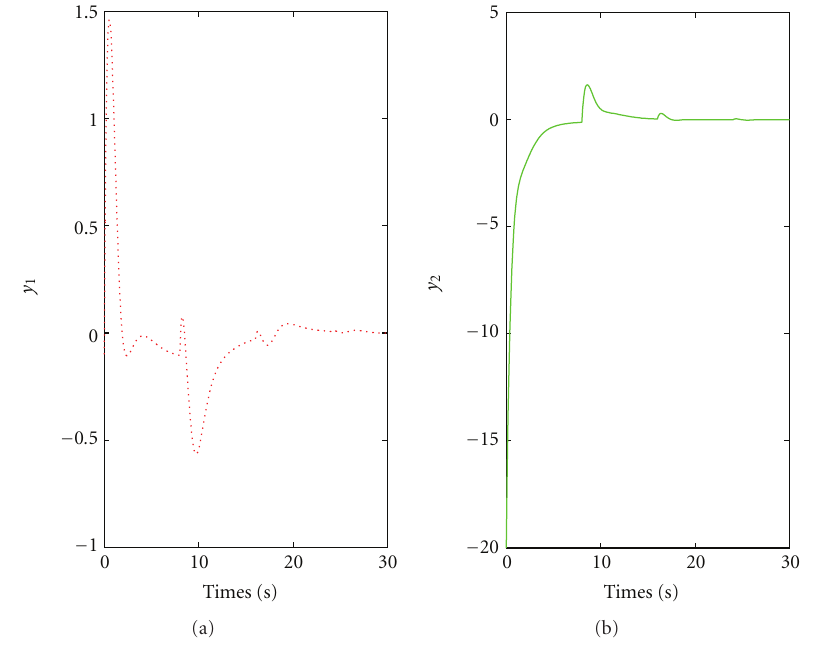
Figure 4: State responses of the closed-loop system when h 3 = 0.